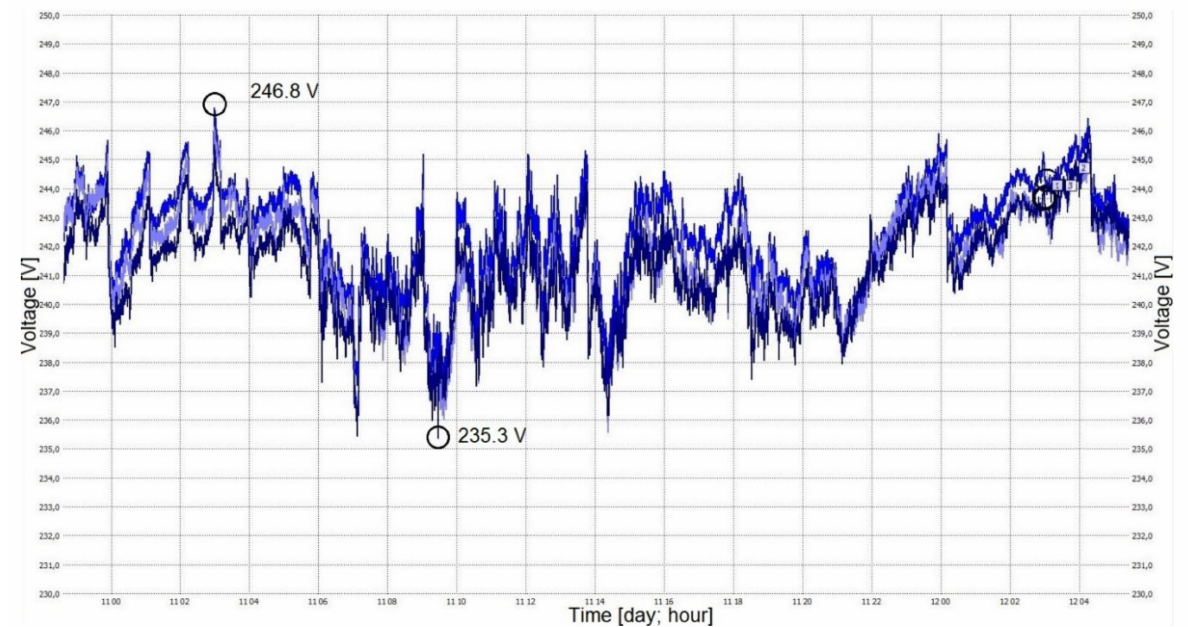
Figure 6. Voltage variations V A in the supply substation (period: 11 June 2021, hour 0:00 a.m. − 12 June 2021, hour 4:00 a.m.).